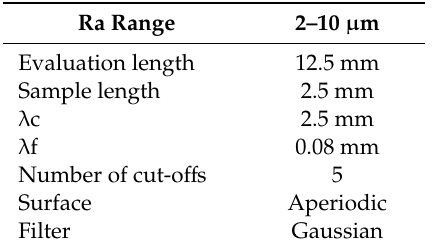
Table 5. Surface roughness measurement specifications.